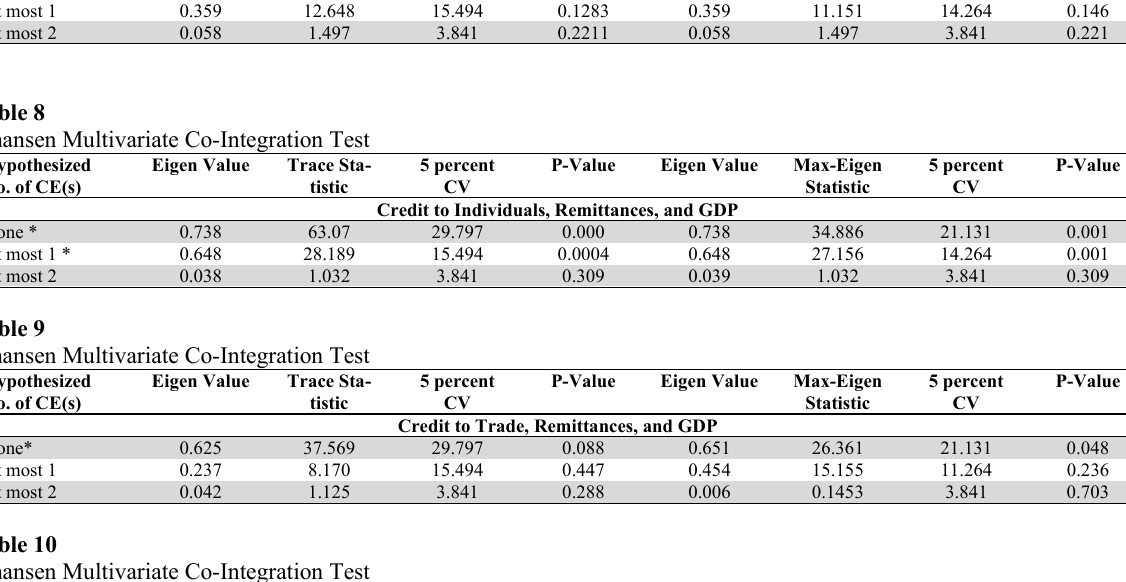
Johansen Multivariate Co-Integration Test Hypothesized No. of